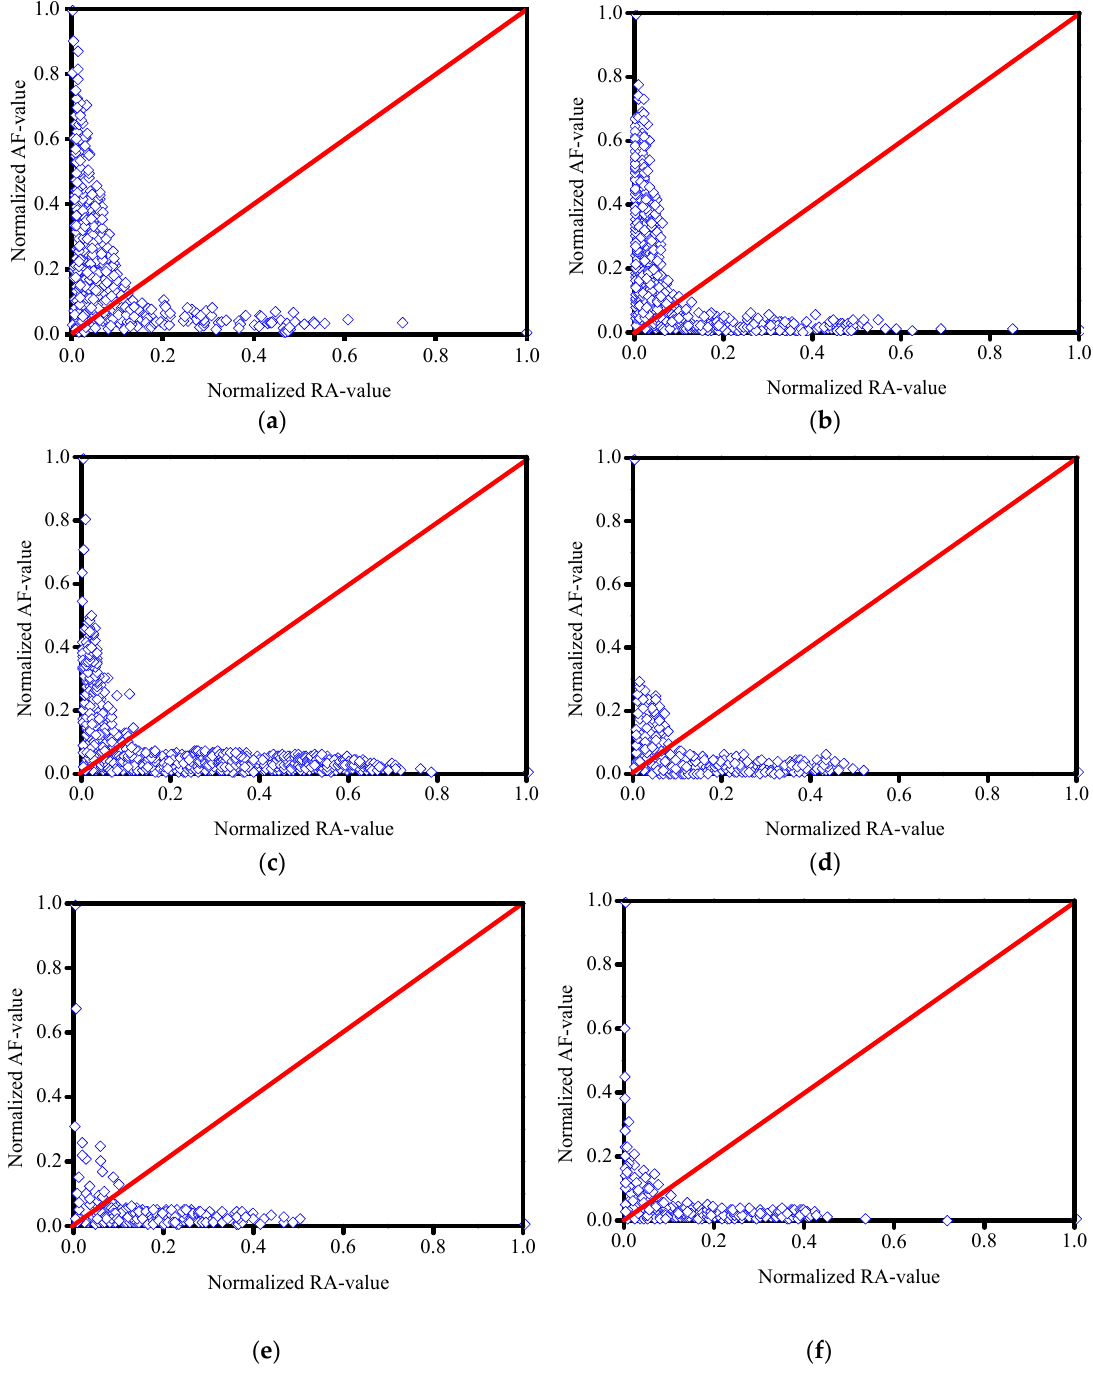
Figure 12. The average frequency ( AF ) and rising angle ( RA ) curves under di ff erent inclination angles at a loading rate of 1 mm / min: ( a ) 0 ◦ ; ( b ) 5 ◦ ; ( c ) 10 ◦ ; ( d ) 15 ◦ ; ( e ) 20 ◦ ; ( f ) 25 ◦